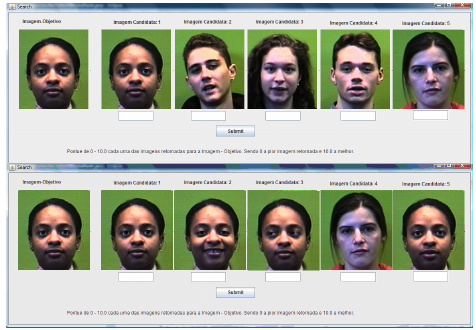
Figure 4. Human face images retrieval using relevance feedback in CBIR [7].